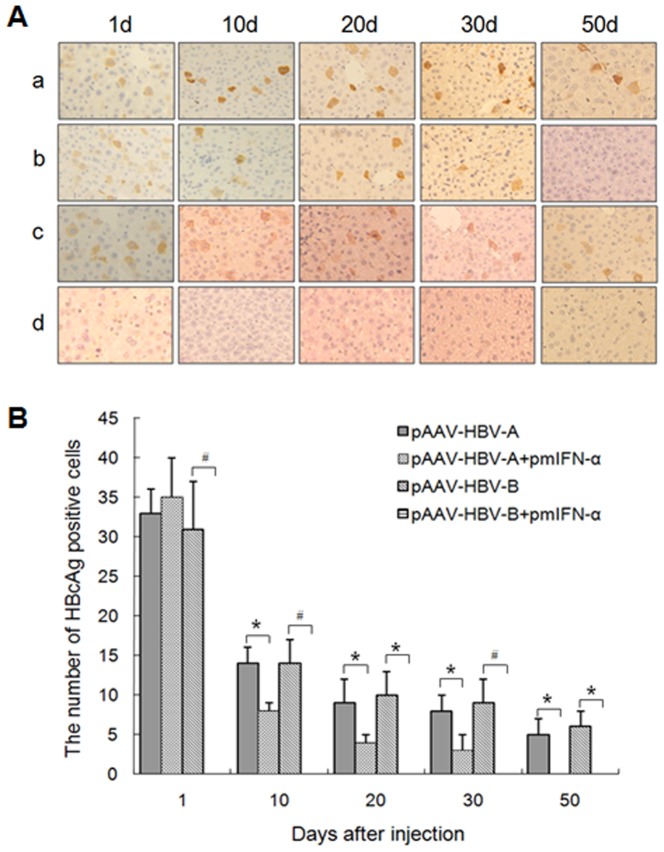
Application of mIFN-α expression vector reduced HBcAg expression in liver of the mice.The mice injected with 10 µg of HBV clones alone or combined wiht 20 µg of pmIFN-α. (A) Immunohistochemical staining of the liver sections for HBcAg in hepatocytes of pAAV-HBV-A- (a), pAAV-HBV-A combined with pmIFN-α- (b), pAAV-HBV-B- (c) and pAAV-HBV-B together with pmIFN-α (d)-injected mice at 1, 10, 20, 30 and 50 dpi (Original magnification: 400X). The mice injected with 0.9% NaCl were used as negative control. Liver specimens of at least three mice per group (n≥3) were analyzed. Each sample was done in duplicate. (B) Frequencies of HBcAg positive cells in the mouse liver sections. The data were analyzed by t test, and the differences were statistically significant (* means p<0.05 and # means p<0.01).